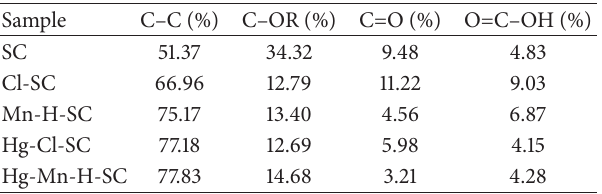
Table 2: Surface carbon functional groups distribution of NM-SC, Cl-SC, and